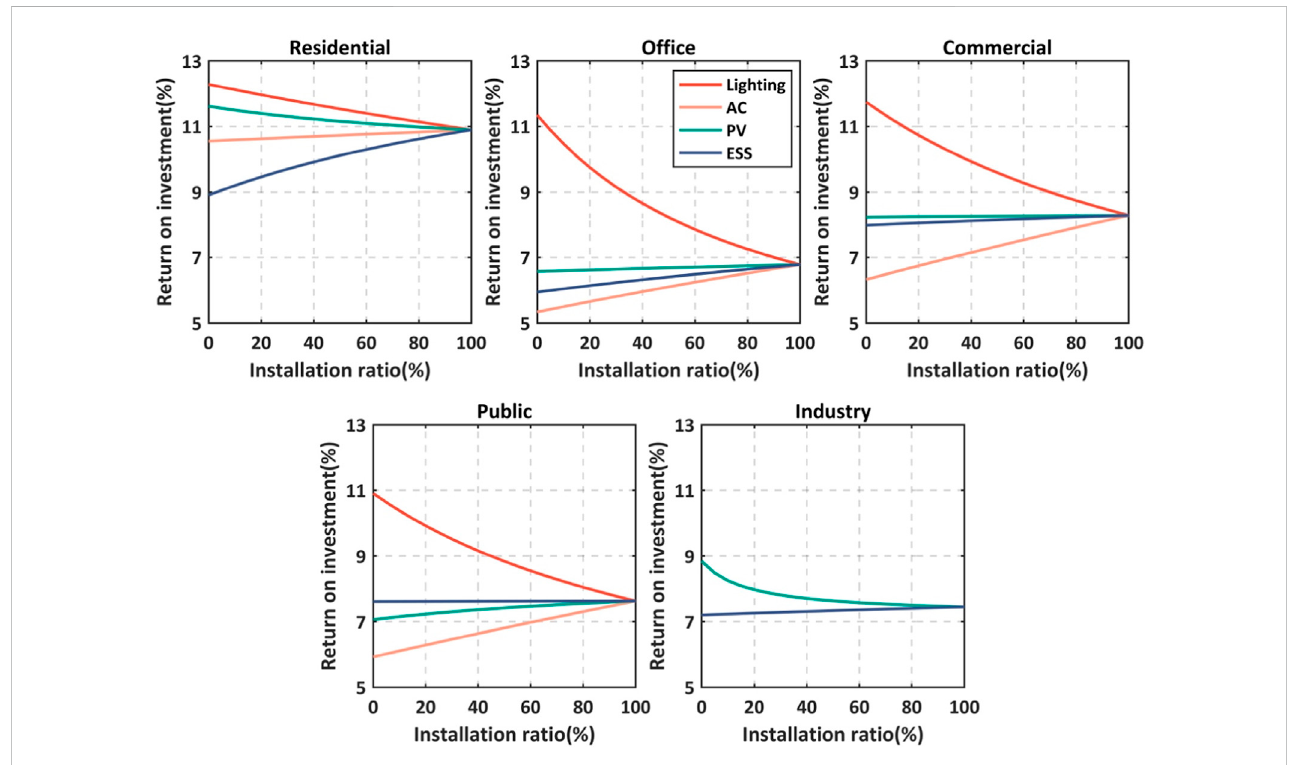
FIGURE 11 Relationship between return on investment and equipment installation